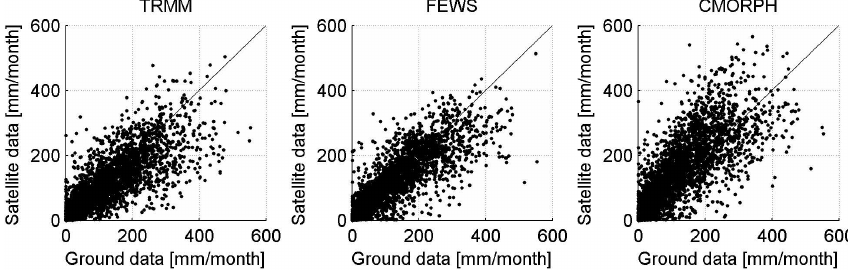
Fig. 8. Scatter plot of satellite estimates versus GPCC data at a monthly time step for the period 2003 to